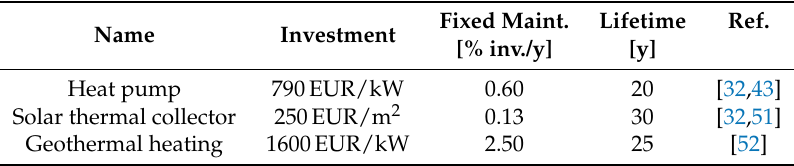
Table A1. Characteristics of used conversion